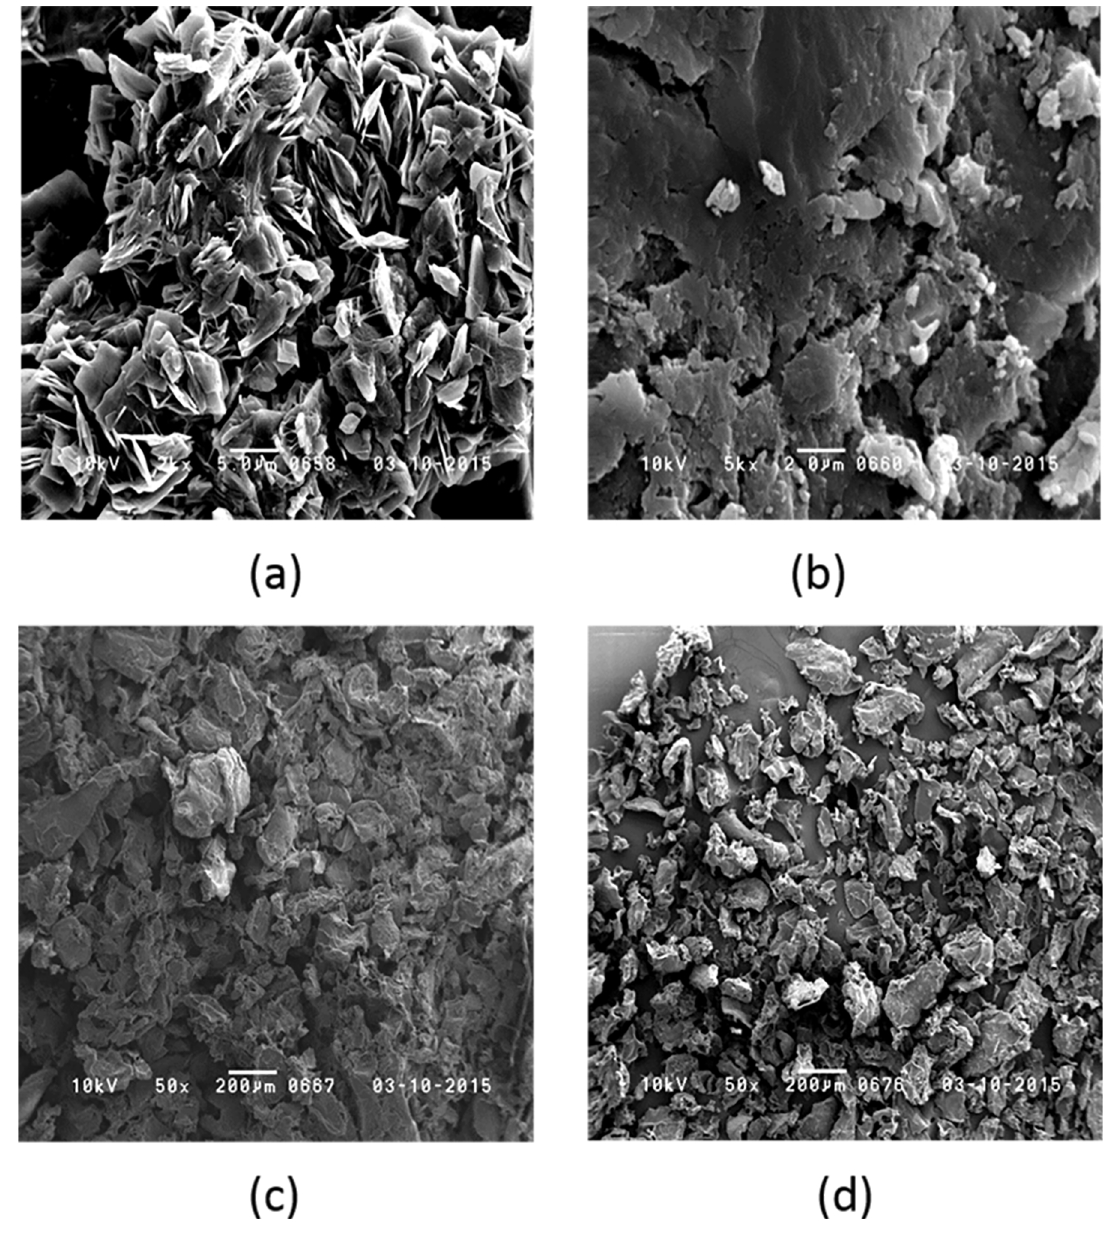
Figure 4. Scanning Electron Microscopy images of (a) CS-GP, (b) CS-GP-GA, (c) lipase immobilized by physical absorption (PA) and (d) lipase immobilized by covalent attachement (CA). value indicated the maximum reaction rate and the K indicated the substrate affinity and enzyme conformational changes, while the catalytic efficiency (V the overall cumulative effect of V activity 28 . The activities of free and immobilized lipases at different substrate concentrations were determined and the kinetic constants were calculated (Table